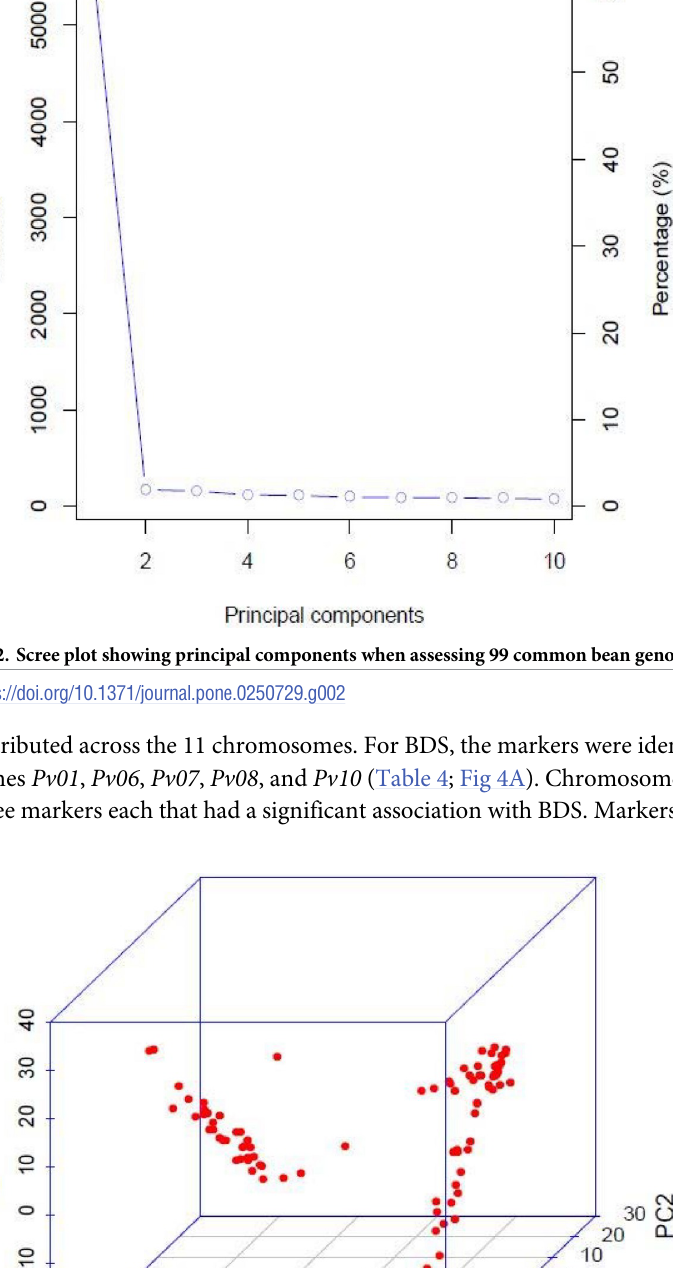
Fig 3. Three dimensional principal coordinate analysis when assessing 99 common bean genotypes with SNP